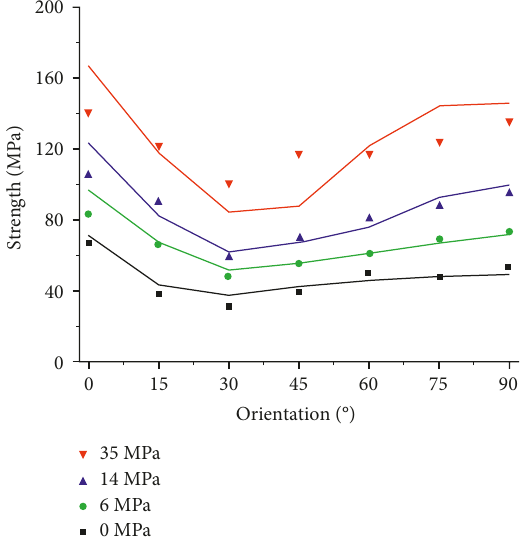
Figure 17: Comparison of strength between simulation and ex- periments under different confining pressures (continuous lines represent simulation results, and scattered points represent ex- periment